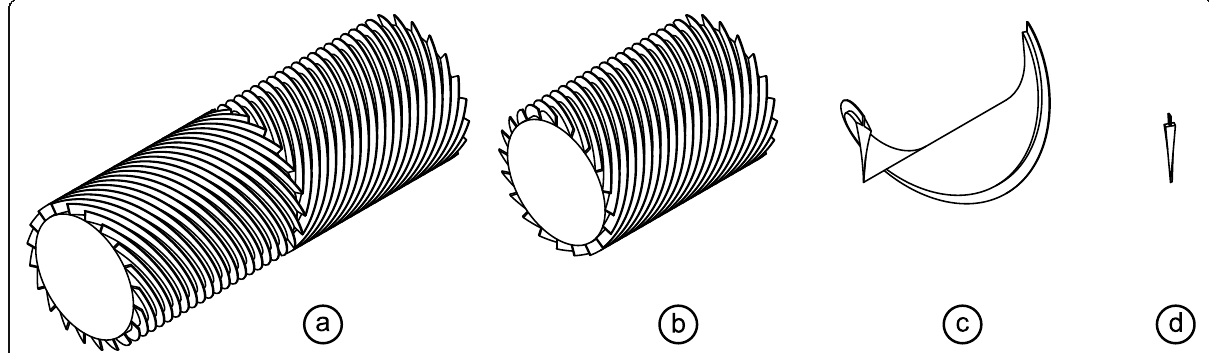
Fig. 4 Model reduction. a Basic Model of the Kniferoller. b Symmetric half cut. c Symmetric helical shape. d Small piece of the helical shape